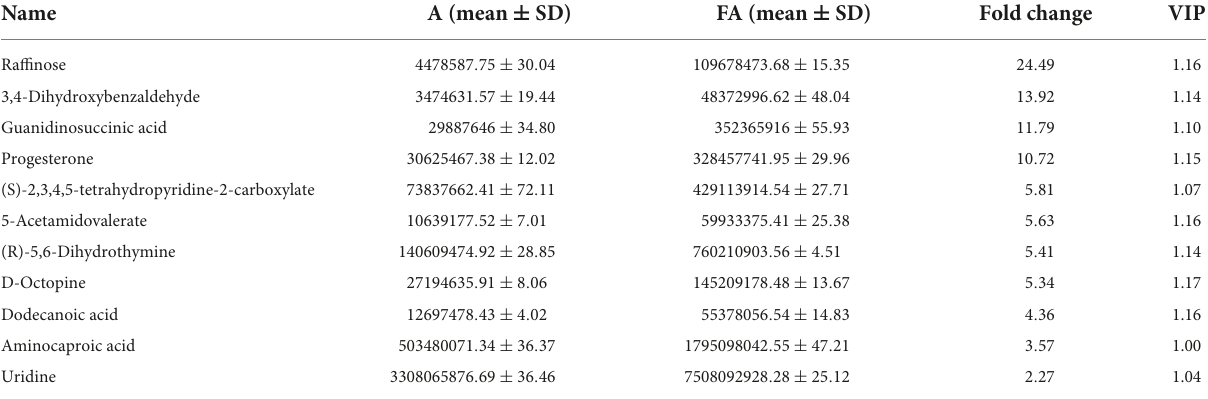
TABLE 1 The significantly increased metabolites in FA vs.